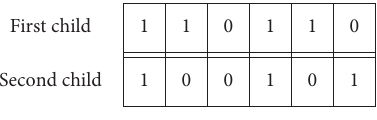
Figure 2: How crossover operator